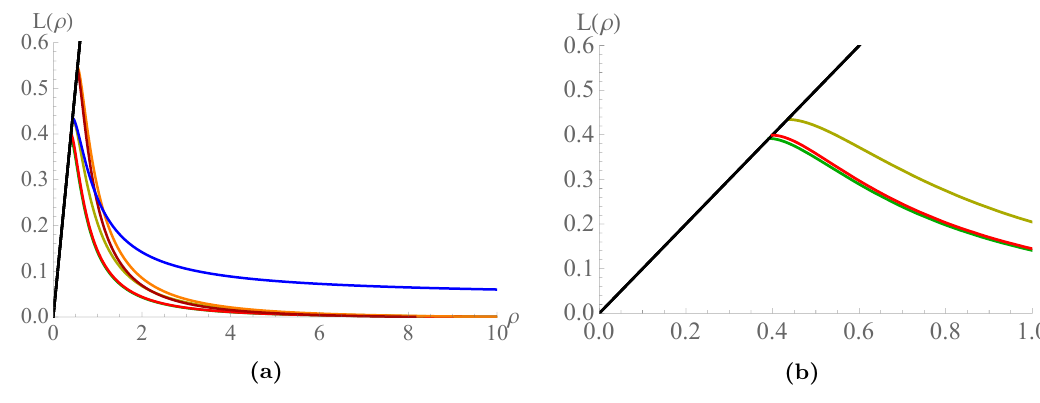
Figure 17. SU(4) 3 F, 3 ¯ F, 5 A 2 — In the left plot we display the vacuum soluions L ( ρ ) : the gold line corresponds to AdS/ SU(4) for the A 2 representation and the green is the fundamental. The red vacuum solution is when we consider the decoupling of the A 2 which condenses before the fundamental. The blue line is the fundamental when we consider additional NJL-terms such that it matches in the IR the A 2 representation. Finally, the orange and purple vacua correspond to the quenched models for the A 2 and fundamental representations respectively. The right hand plot is a zoom in when considering the AdS/ SU(4) model without decoupling and when we consider the decoupling of the A 2 quark